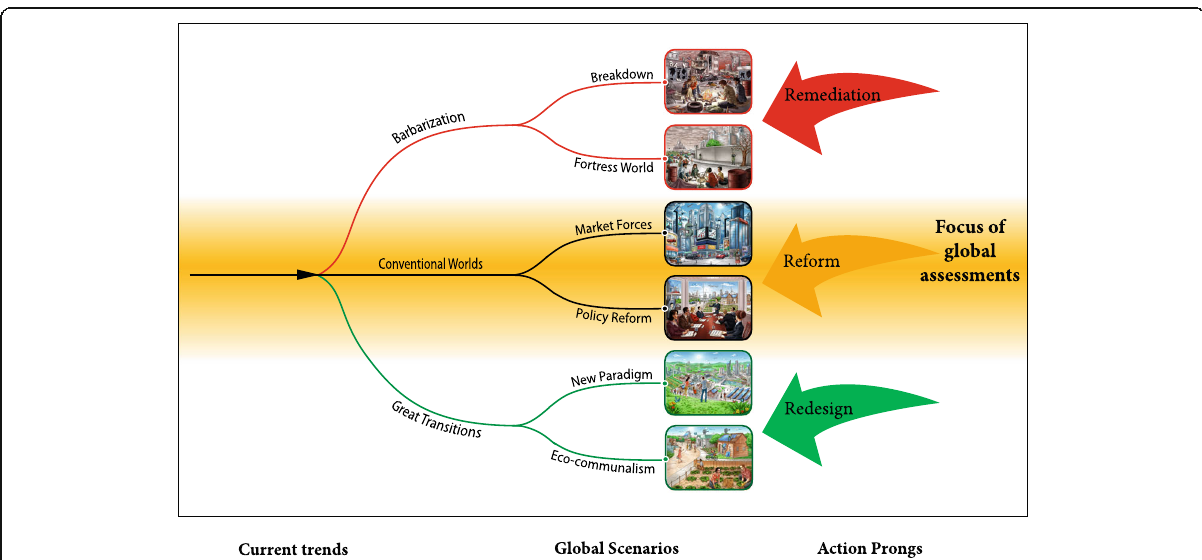
Fig. 1 Excluded Futures and the Continuity Bias. See https://greattransition.org/explore/scenarios/excludedfutures to view an enlarged image and scenario